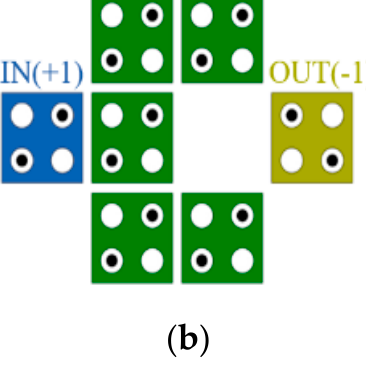
Figure 2. Inverters: ( a ) week inverter; ( b ) robust inverter.